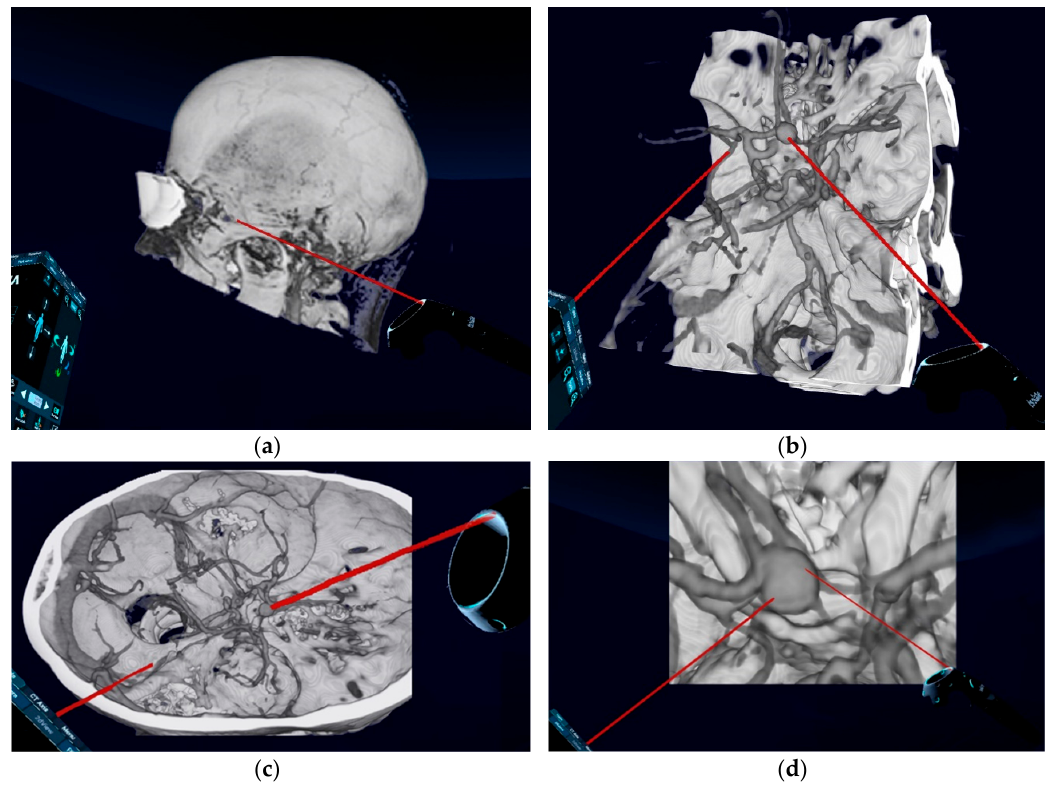
Figure 3. Preoperative reconstructed 3D ‐ virtual reality images of patients with unruptured ACoA aneurysm. ( a ) Lateral aspect of the skull; ( b ) oblique superior aspect of the aneurysm and relevant vascular anatomy and the skull base; ( c ) lateral superior aspect of the aneurysm and relevant vascular anatomy and the skull base; ( d ) zoomed superior aspect of aneurysm and relevant vascular anatomy. 3D, three ‐ dimensional.